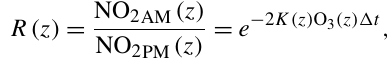
2 O 5 in the past few